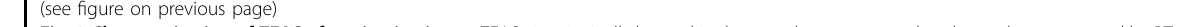
Fig. 2 Characterization of ZFAS1 function in vitro. a ZFAS1 is principally located in the cytoplasm, compared to the nucleus, measured by RTqPCR in all three colon cancer cell lines (HT29: 76% vs. 24%, p = 0.02, SW480: 84% vs. 16%, p = 0.03, Caco2: 77% vs. 23%, p = 0.005, n = 6 replicates). b RTqPCR shows ef fi cient knockdown of ZFAS1 with ZFAS1 siRNA in all three cell lines compared to non-target siRNA (all > 70%, all * p < 0.05, n = 6 replicates). c There is no decrease in the cell viability (percentage of viable cells compared to all counted cells) with ZFAS1 knockdown compared to cells transfected with non-target siRNA ( n = 6 replicates). d There is signi fi cant decrease in the cellular proliferation with ZFAS1 knockdown in the HT29 cell lines, by examining the doubling time (34.3 h vs. 30.6 h, p = 0.046), the individual counts at 96 h (** p = 0.03), and the counts at 120 h (*** p = 0.02) ( n = 6 replicates). e There is signi fi cant decrease in the cellular proliferation with ZFAS1 knockdown in the SW480 cell lines, by examining the doubling time (42.5 h vs. 31.5 h, p = 0.01), and the individual counts at 72 h (** p = 0.03), 96 h (** p = 0.03), and 120 h ( Ϯ p = 0.01) ( n = 6 replicates). f There is signi fi cantly decreased migration of cells with ZFAS1 knockdown in the HT29 cell line (*** p = 0.02, n = 6 replicates) The panels on the right show representative ×10 magni fi cation fi elds of the HT29 cell line transwell migration assay (top panel ZFAS1 knockdown, bottom panel non-target siRNA). g There is signi fi cantly decreased migration of cells with ZFAS1 knockdown in the SW480 cell line (** p = 0.03, n = 6 replicates). The panels on the right show representative ×10 magni fi cation fi elds of the SW480 cell line transwell migration assay (top panel ZFAS1 knockdown, bottom panel non-target siRNA). h There is signi fi cantly decreased invasion of cells with ZFAS1 knockdown in the HT29 cell line (*** p = 0.02, n = 6 replicates) The panels on the right show representative ×10 magni fi cation fi elds of the HT29 cell line transwell invasion (top panel ZFAS1 knockdown, bottom panel non-target siRNA). i There is signi fi cantly decreased invasion of cells with ZFAS1 knockdown in the SW480 cell line (** p = 0.03, n = 6 replicates). The panels on the right show representative ×10 magni fi cation fi elds of the SW480 cell line transwell invasion (top panel ZFAS1 knockdown, bottom panel non-target siRNA). j There was a signi fi cantly slower scratch closure of the HT29 cell line with ZFAS1 knockdown compared to control ( ϮϮ p = 0.004, n = 11 replicates). The panels on the right show representative ×4 magni fi cation fi elds of the HT29 scratch assay (top panels scratch closure following ZFAS1 knockdown at time 0 and at 120 h, bottom panels scratch closure with non-target siRNA at time 0 and at 120 h). k There was a sign fi ciantly slower scratch closure of the SW480 cell lines with ZFAS1 knockdown compared to control ( ϮϮϮ p < 0.001, n = 6 replicates). The panels on the right show representative ×4 magni fi cation fi elds of the SW480 scratch assay (top panels scratch closure following